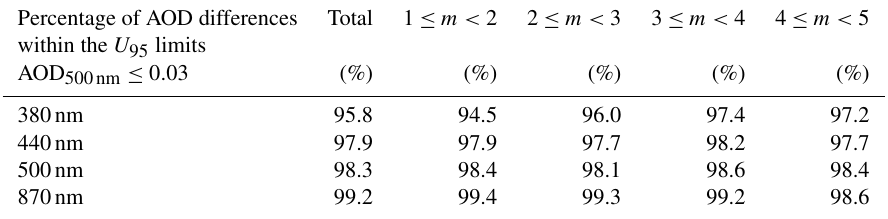
Table 7. Percentage of 1min AOD data (V2) meeting the WMO criteria for each wavelength for different optical air mass intervals under pristine conditions (AOD 500nm ≤ 0 . 03) in the period 2005–2015. See Supplement S5 for equivalent results with V3.